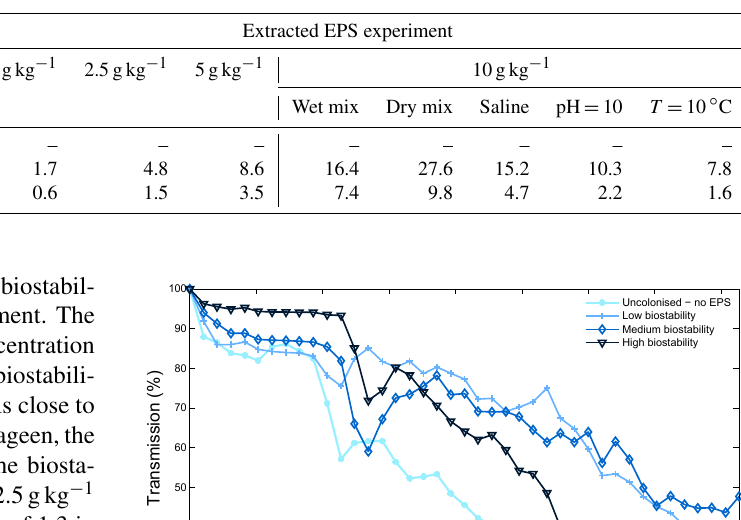
Table 2. Biostabilisation index resulting from natural biofilm colonisation and the addition of extracted EPSs xanthan gum and carrageenan to sand.